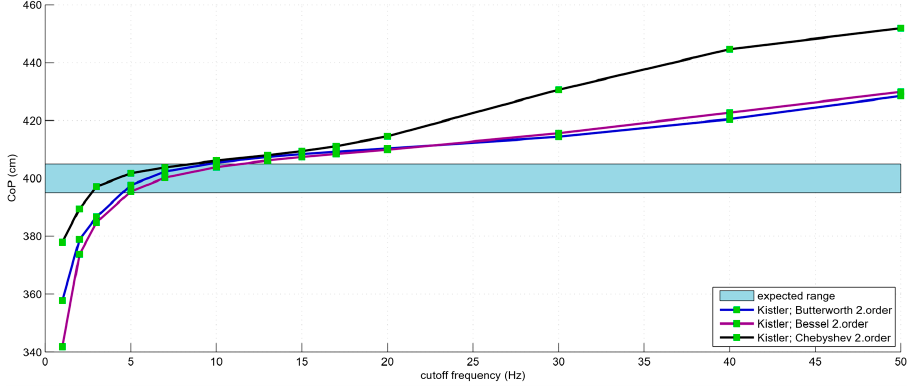
Figure 5. Representation of the characteristic curves of second-order Bessel, Butterworth, and Chebyshev filters.